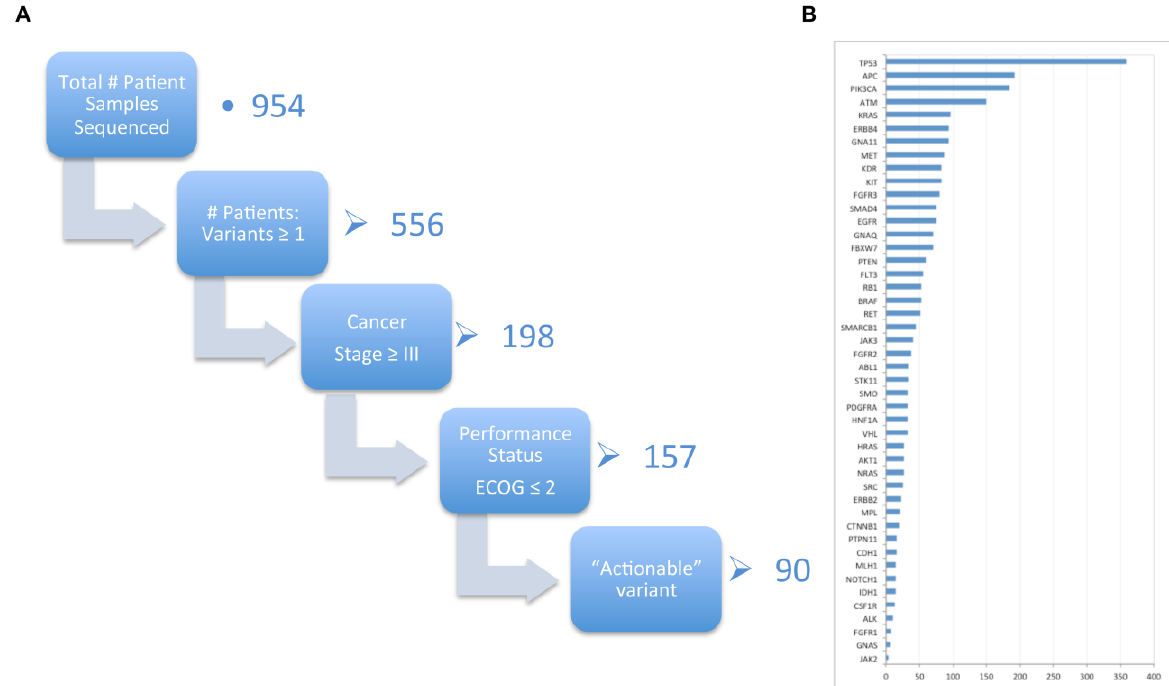
Figure 3. ( A ) The number of Cancer 2015 patients that have had tumour sample DNA sequenced, binned into those with at least one gene somatic variant identified; having advanced cancer (Stage Group ≥3); having an Eastern Co-operative Oncology Group (ECOG) Performance status of ≤2 (“no worse than ambulatory and capable of all self care but unable to carry out any work activities. Up and about more than 50% of waking hours”) and finally the variant(s) are deemed “actionable” ( i . e ., approved drugs available or drugs in clinical trials); ( B ) Comparison of the number of mutations observed per gene represented overall across all solid tumour histo-types in the